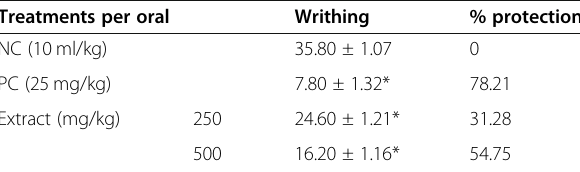
Table 4 Effects of B. pilosa ethanol extract and controls on acetic acid induced writhing mice Treatments per